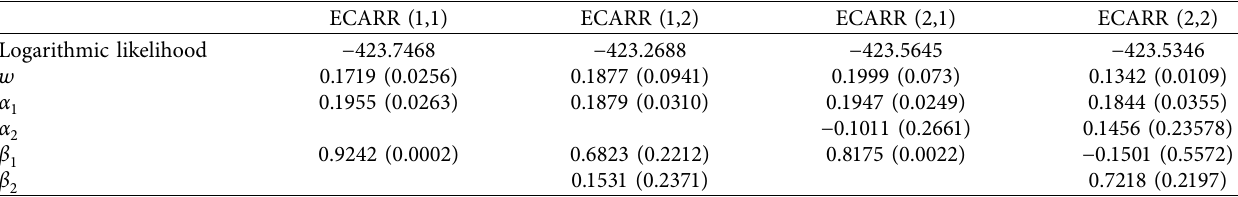
Table 2: Comparison of different lag order estimation results of the ECARR model based on B segment weekly